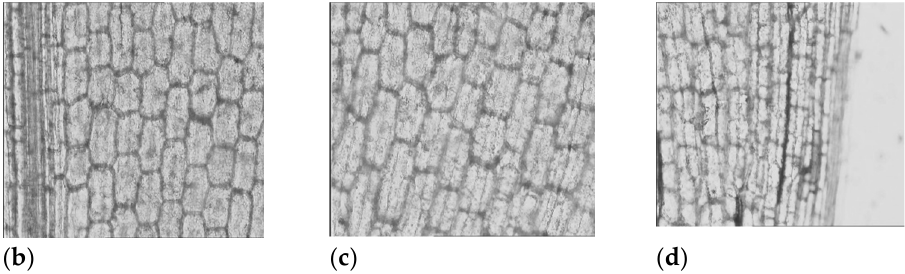
Figure 4. Results of the tritium action on the movement of chloroplasts of the Elodea leaves in the experiments with water from the Yenisei River—14 days, ( a – c ): ( a ) control (~4 Bq·L −1 ), ( b ) +100 Bq · L −1 , ( c ) +2900 Bq · L −1 ; and with water from Atomic Lake—5 days, ( d ): tritium content of 5600 Bq · L −1 in the mixture with other radionuclides.